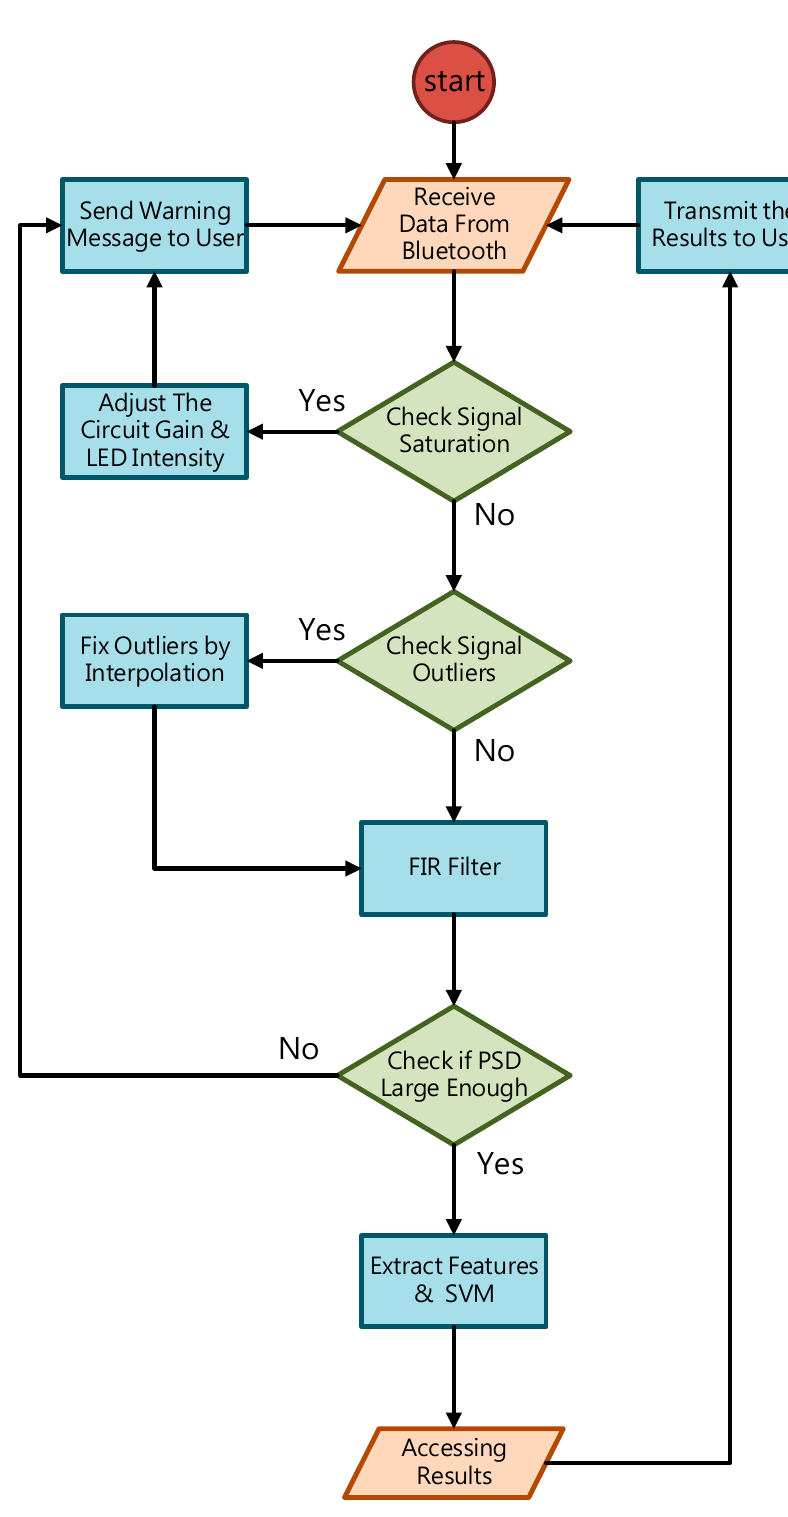
Figure 6. The flow chart of the digital signal processing in the proposed PPG sensor system.